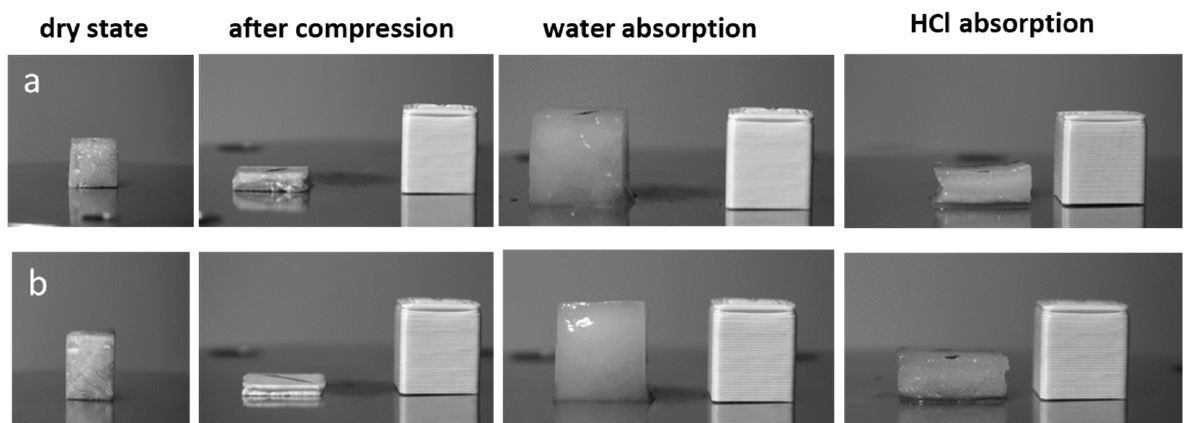
Figure 3. CNF aerogel (2%, UD freezing) at ( a ) 100:0 CNF/XG and ( b ) 60:40 CNF/XG in dry cubic shape, after compression, and after water absorption or after HCl 100 mM absorption. Cubic specimen in polylactide (PLA) at right is used as refer- ence.